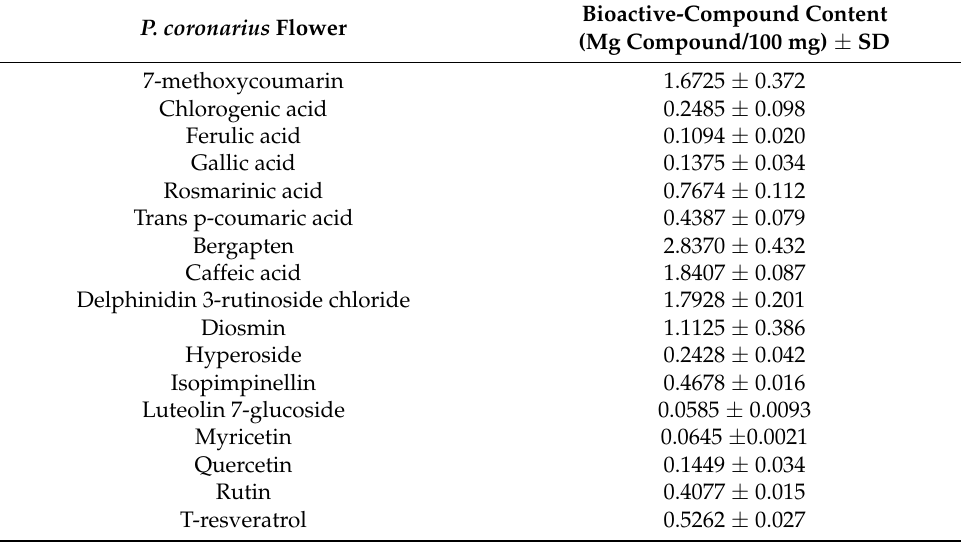
Table 2. Bioactive-compound content of P. coronarius